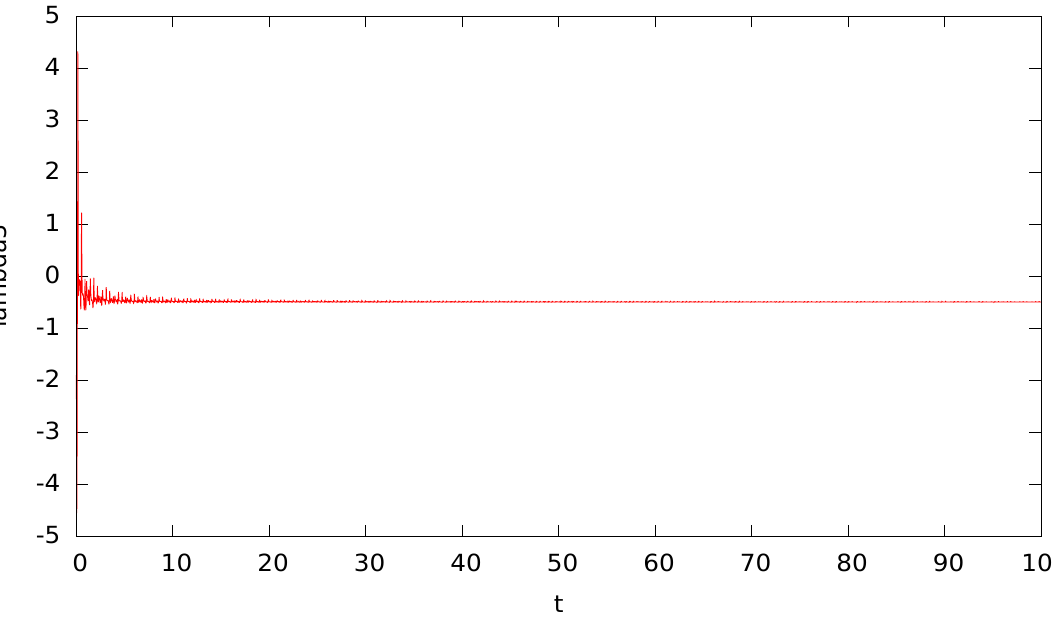
Figure 5. The graph of the change in time of the Lyapunov exponent LE 3